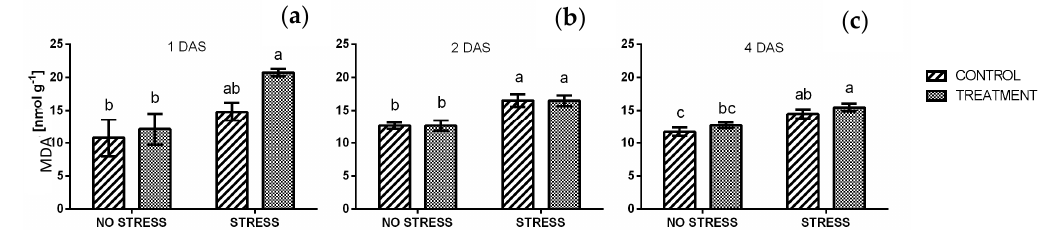
Figure 10. Concentration of malondialdehyde (MDA) in rocket leaves treated with water (CONTROL) and with borage extract (TREATMENT) and subjected to salt stress (200 mM). Measures were taken one day ( a ), two days, ( b ) and four days ( c ) of stress. Values are means ± SE ( n = 4). Data were subjected to two-way ANOVA. Different letters, where present, represent significant differences ( p < 0.05).